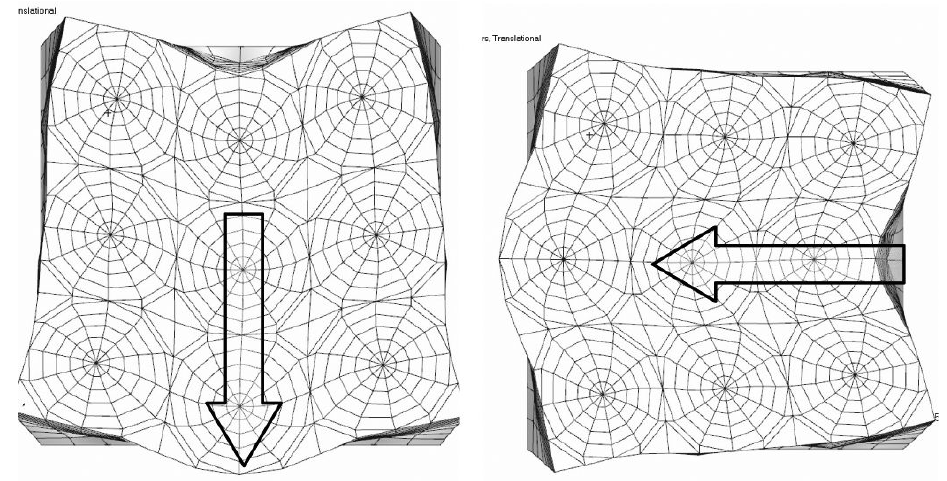
Fig. 29. 5th (left) and 6th (right) mode: − 1139 Hz X, Z none uniform translation. (Fig. 34) and 15th (Fig. 35) modes, where mutual rotational and mutual transitional modes are shown respectively at the 1 Hz to 2200 Hz frequency